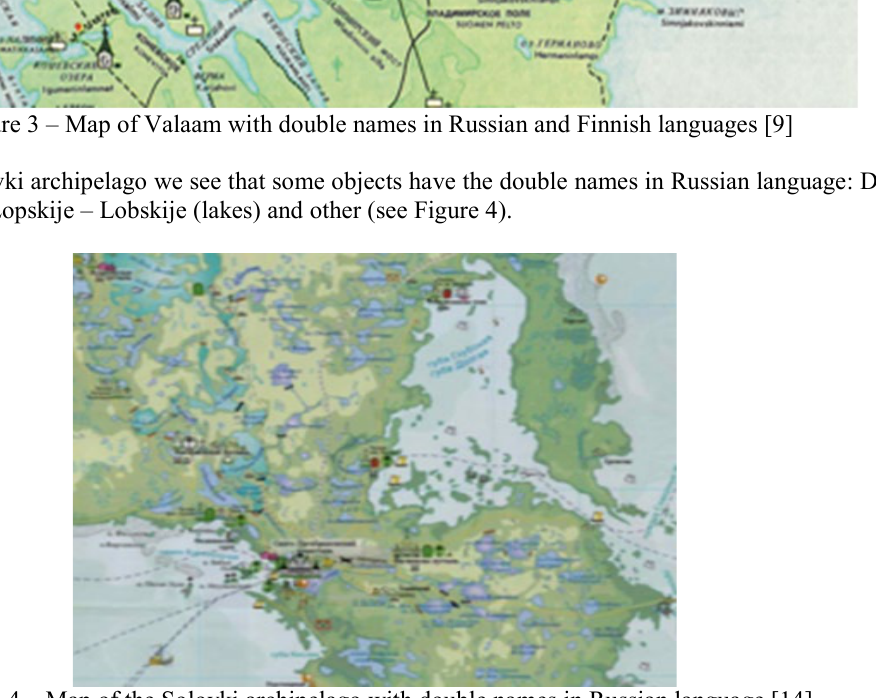
Figure 4 – Map of the Solovki archipelago with double names in Russian language [14]